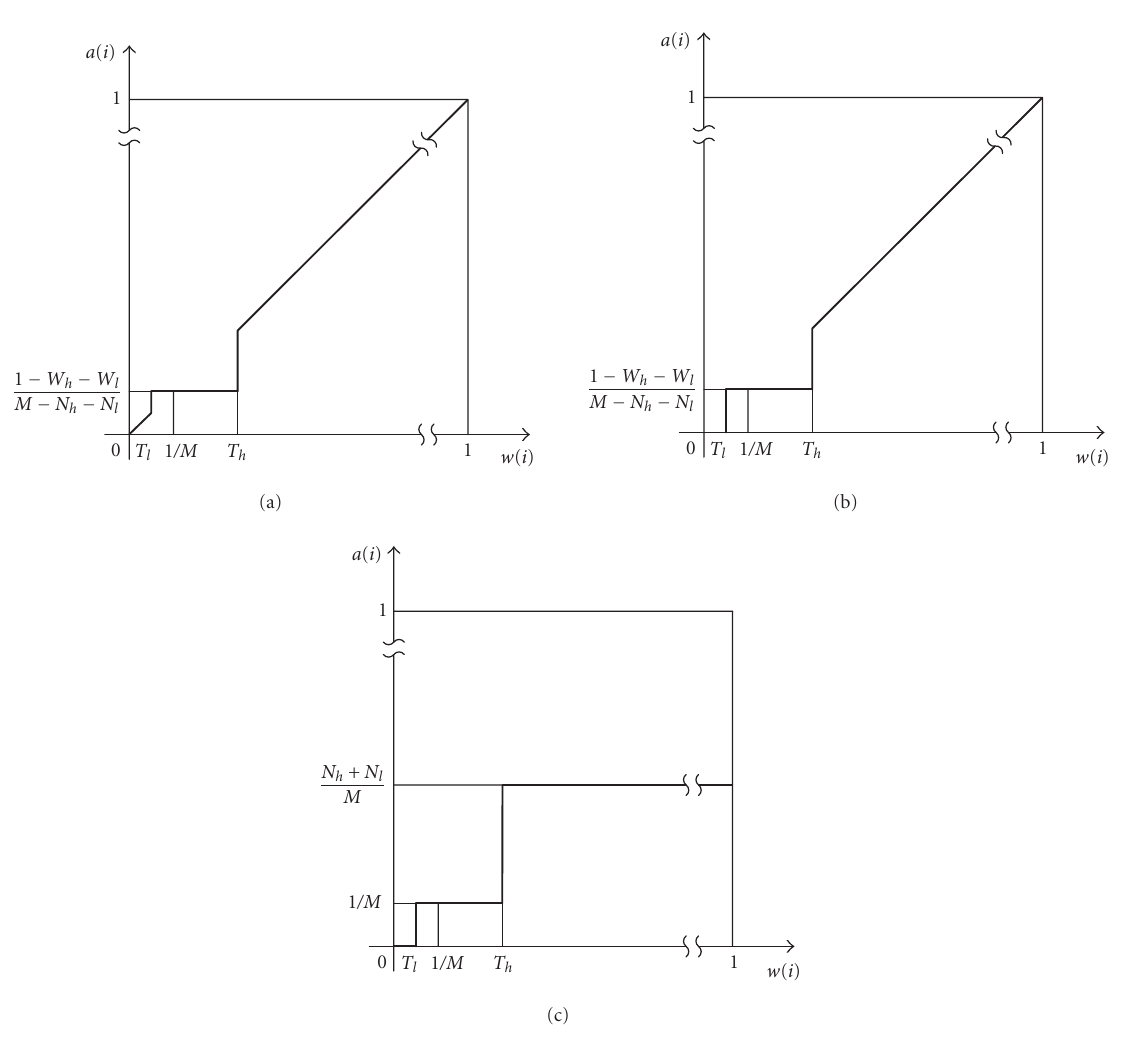
Figure 3: Resampling functions for the PR algorithms (a) PR1, (b) PR2, and (c)